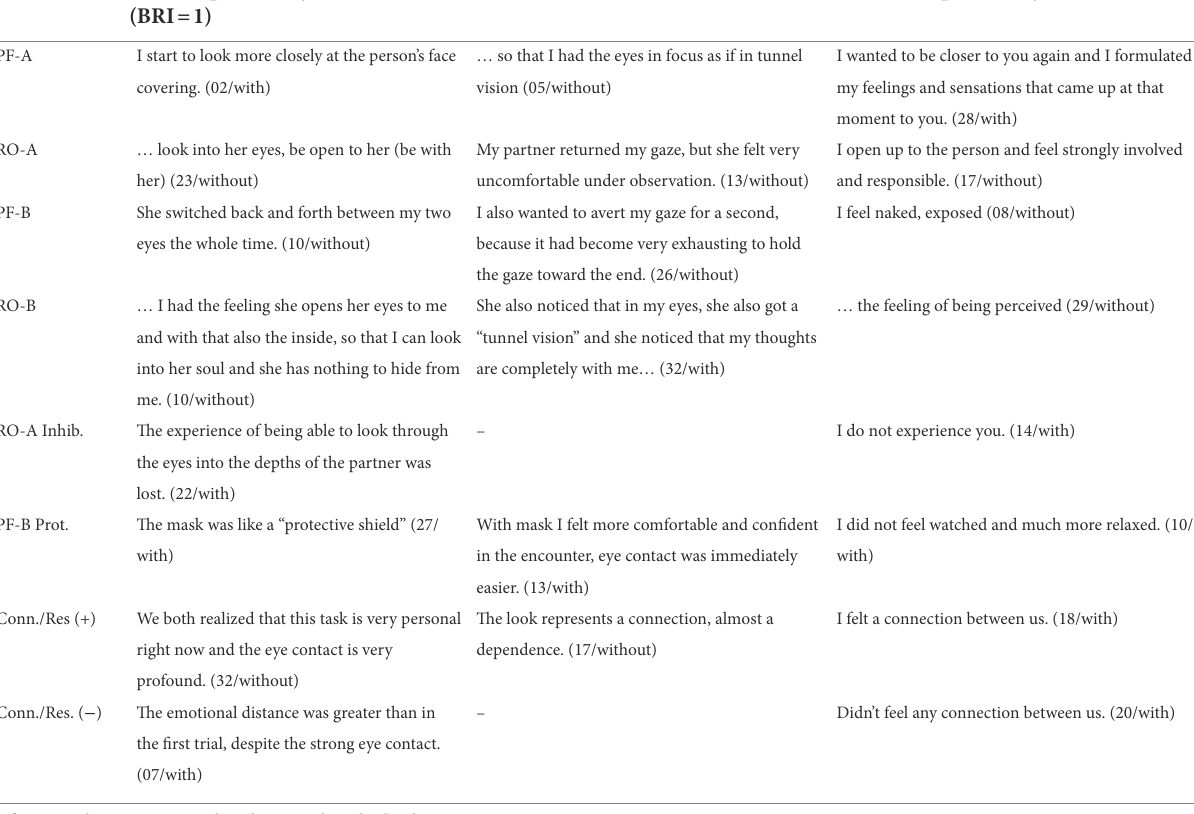
TABLE 4 Level 3: Varying dependence on body reference (exemplary codings). With explicit body ref.